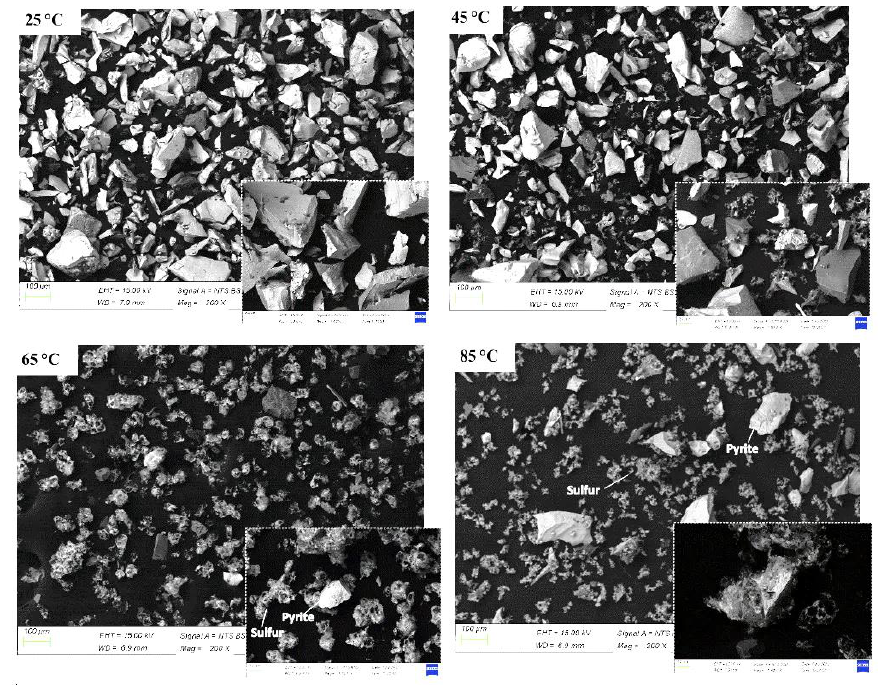
Figure 16. SEM images of pyrite residue at different temperatures of 25, 45, 65, and 85 °C.